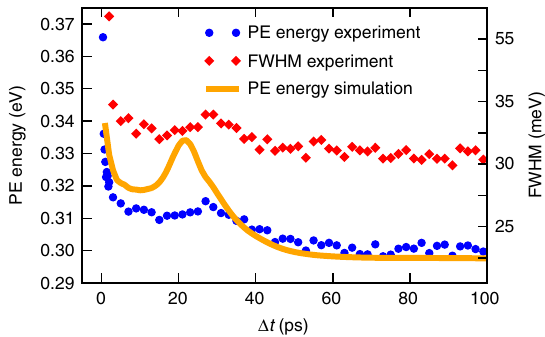
Fig. 3 Photoelectron (PE) peak position and linewidth as a function of time delay Δ t . The transient peak position (blue dots) and full width at half maximum (FWHM, red diamonds) are shown within 100 ps after photoexcitation, as measured with TRPES and simulated with TDDFT (orange line). The experimental peak position and FWHM are obtained by Gaussian fi ts to the corresponding PE energy spectra. The start position for the TDDFT simulation was 20 Å from the droplet center in order to obtain a similar ejection behavior as the red diamonds) with a steady decrease over time to about 35 meV Fig. 7b. We note that except for very short time delays right after the pump – probe overlap (cross-correlation), the total PE yield stays constant over the whole investigated temporal region.